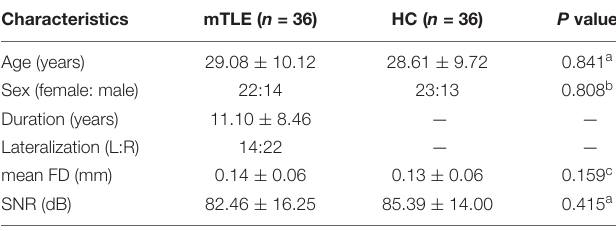
TABLE 1 | Demographic and clinical information of subjects.